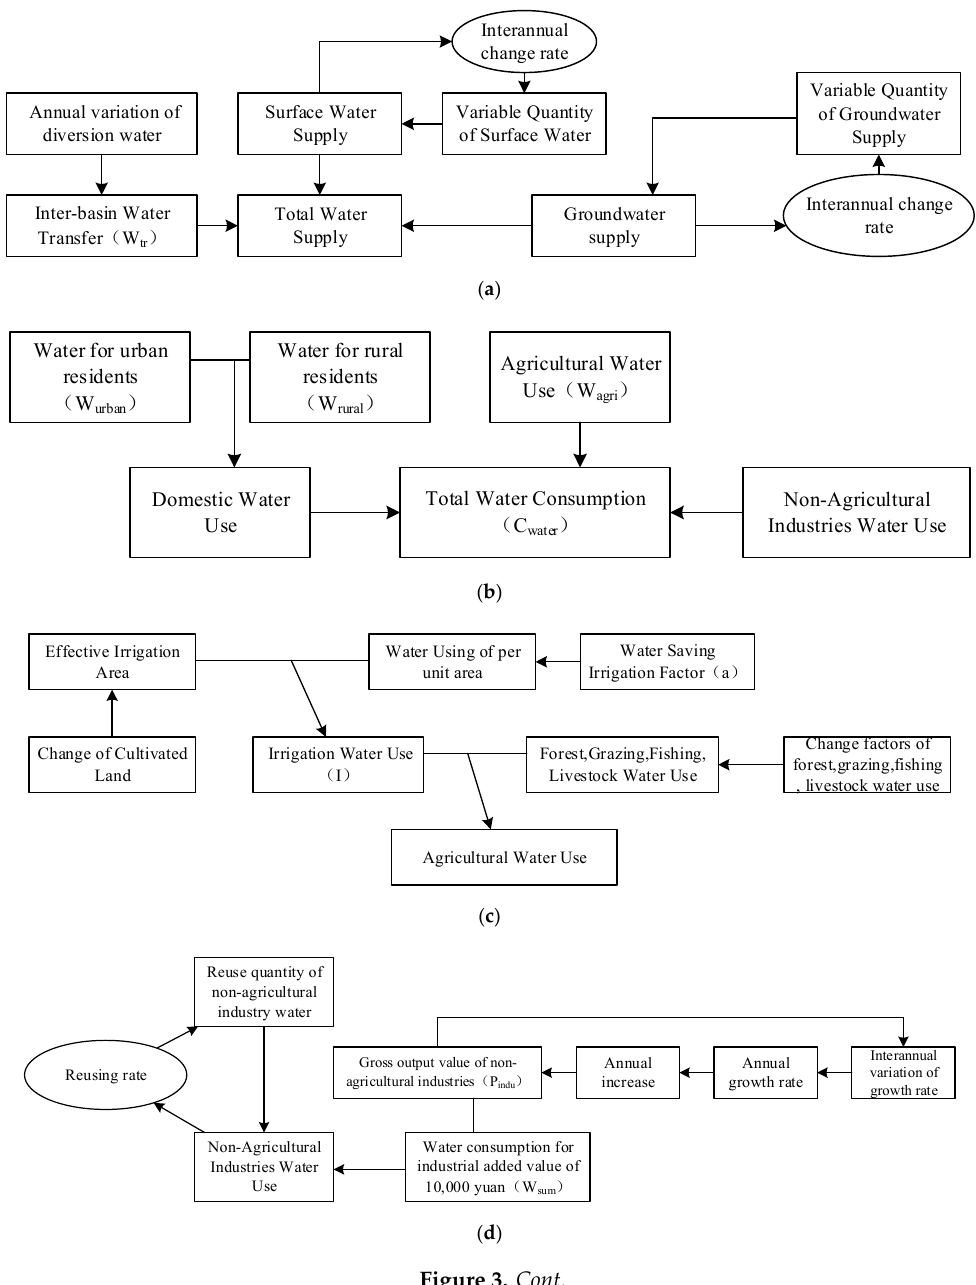
Figure 2. Modeling the variations of water resources carrying capacity in Xiong’an New